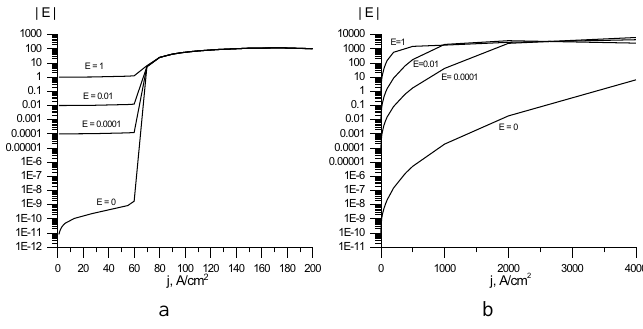
Figure 4. Scheme of quasi-Cherenkov VFEL in Laue geometry.